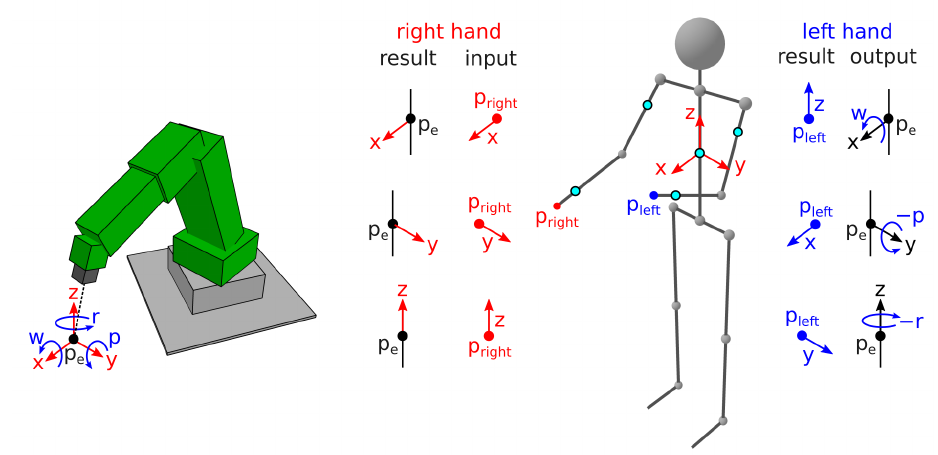
Figure 5. The robot controls using the developed teleoperation